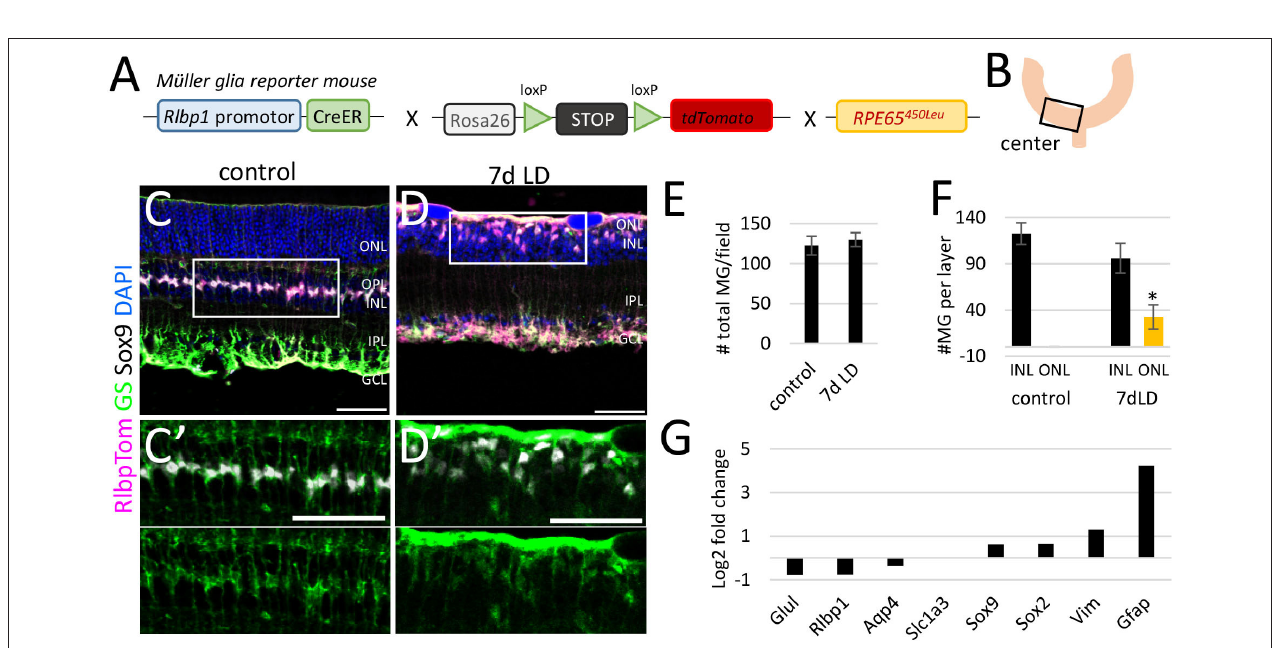
FIGURE 1 | photoreceptors in the ONL of the central retina in controls and 7 days after light damage (7d LD). (H) Number of vertical cell rows of Otx2 + photoreceptors in the ONL of the peripheral retina in controls and 7 days after light damage (7d LD). (I–M/M ′ ) Immunofluorescence labeling for tdTomato (MG) and GFAP of an entire retinal cross section (I) , in the central (J/J ′ -K/K ′ ) and peripheral areas (L/L ′ -M/M ′ ) of undamaged and light damaged (7d LD) retinal sections. (N/N ′ -S/S ′ ) Immunofluorescence labeling for tdTomato (MG), GFAP, and DAPI nuclear staining of the center retina 12h, 1, 2, 3, and 5 days as well as 6 weeks after